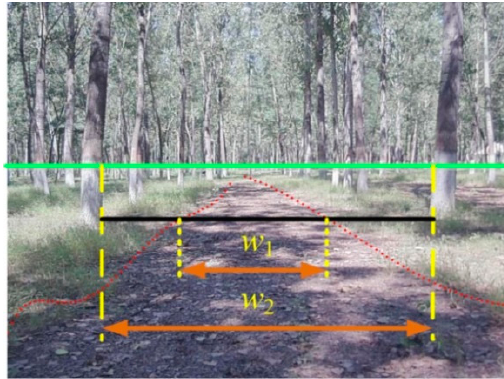
Figure 5. Schematic of remapping relationship. The red dashed line represents the road boundary fitted to the image. The solid green line is the horizontal line scanned by lidar. w 2 is the distance between two obstacles in front of the vehicle based on the 2D laser point cloud measurement. w 1 is the width of the road of pixels corresponding to w 2